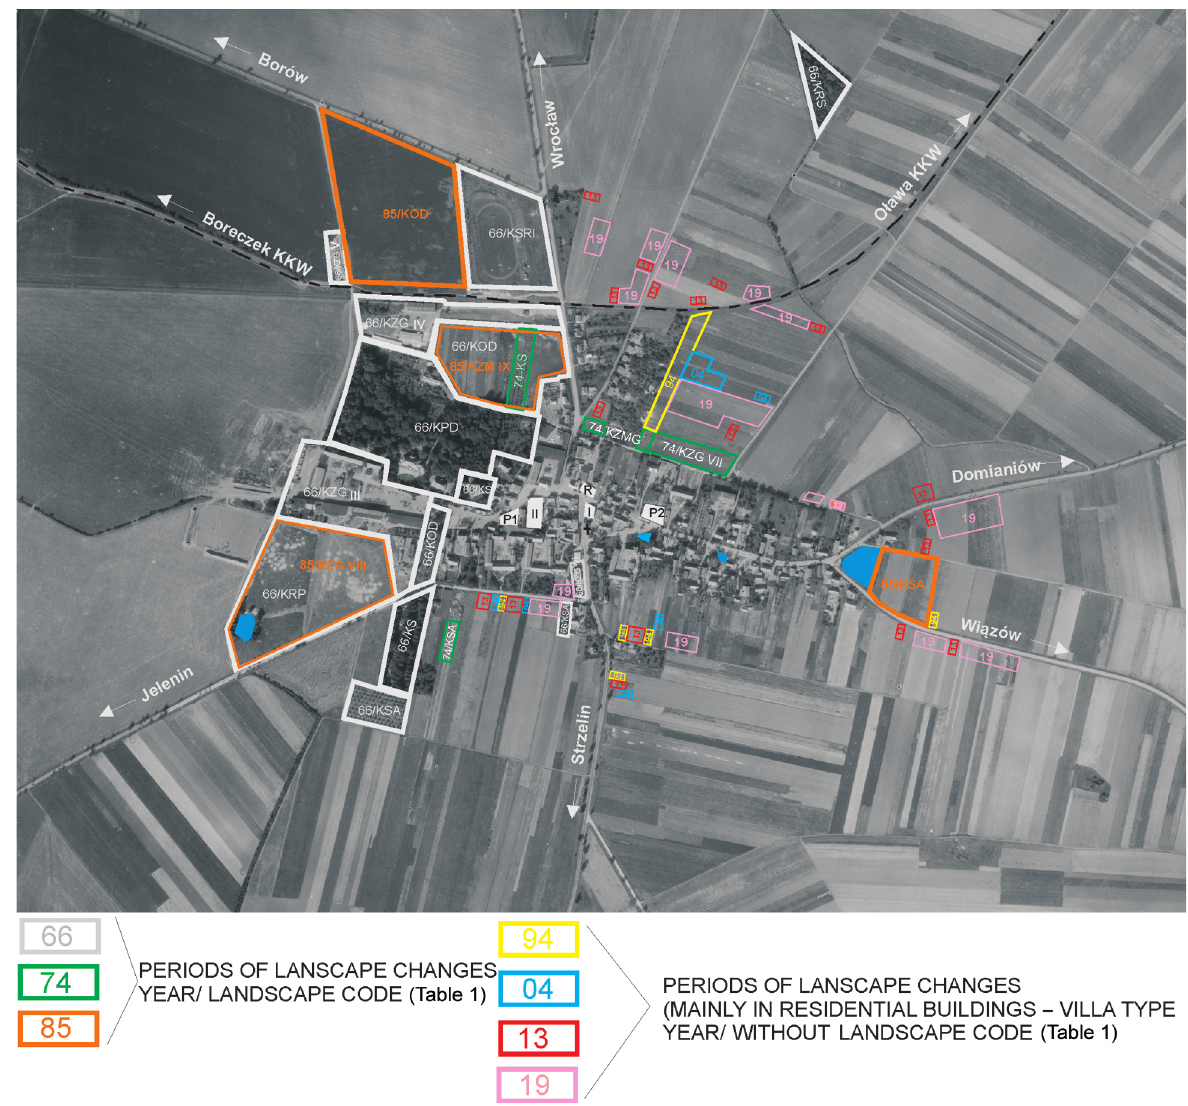
Fig. 2. Structure and function of landscape transformation of Borek Strzeliński in the period 1966–2019. Source: J.